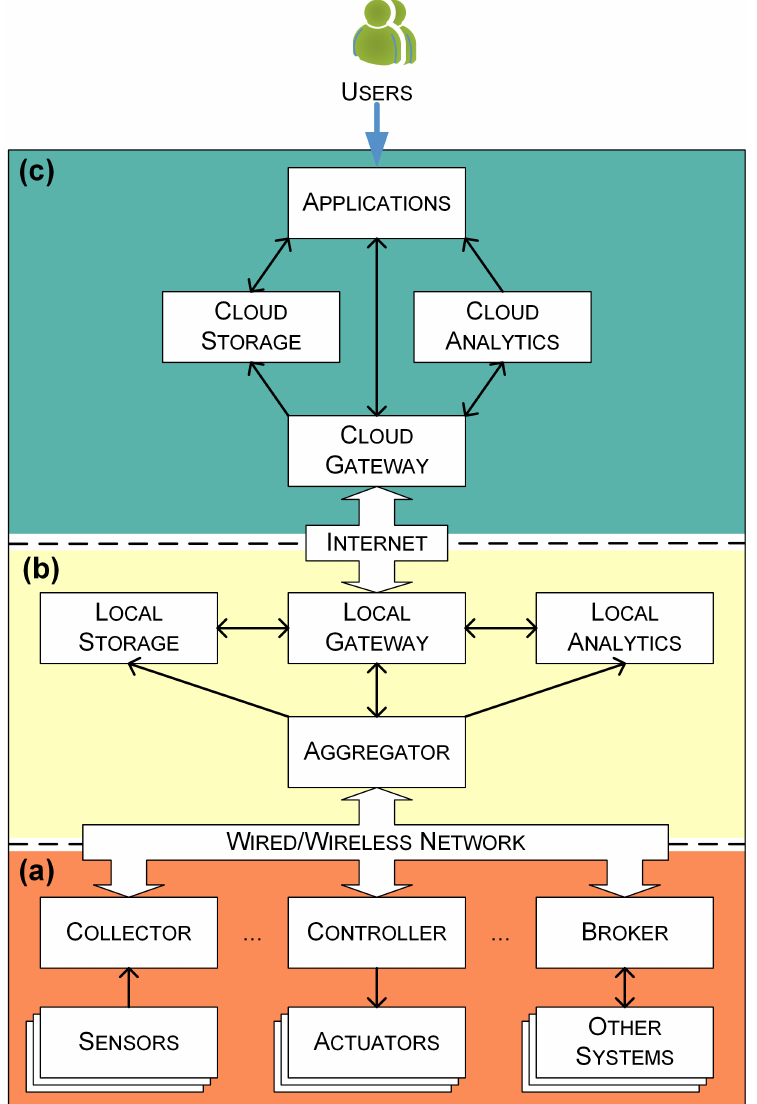
Figure 1. Architecture of the proposed digitalization framework. ( a ) Perception Devices, ( b ) Edge Platform, and ( c ) Cloud